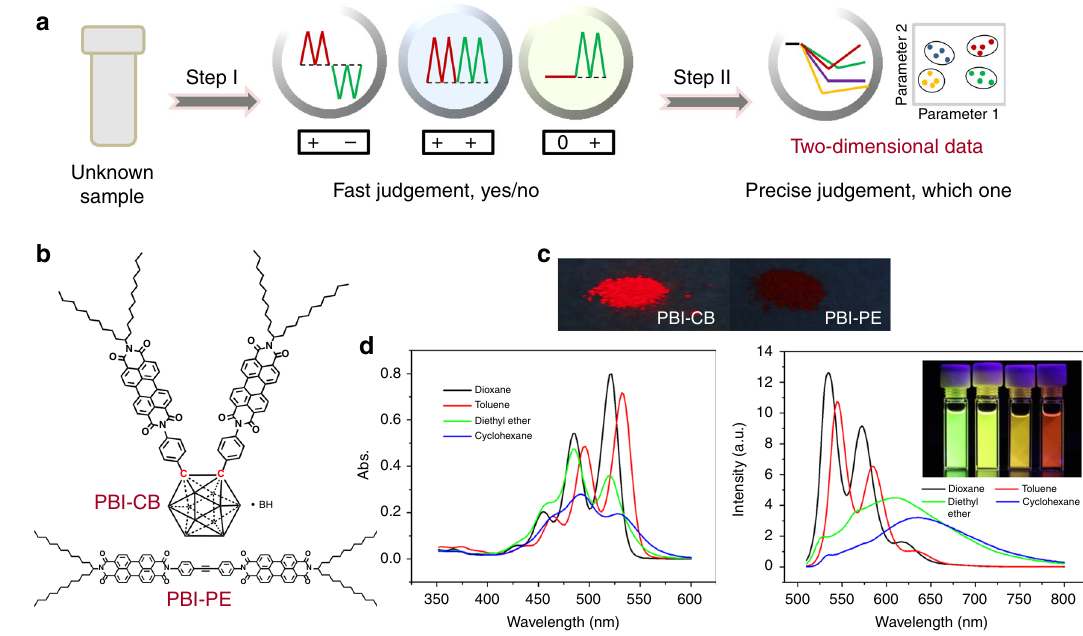
Fig. 1 Analytical strategy and fl uorescent property of PBI-CB. a Schematic representation of the two-step judgment strategy for differentiation and identi fi cation of illicit drugs via scent snif fi ng. b Chemical structures of PBI-CB and PBI-PE. c Fluorescent images of PBI-CB and PBI-PE in solid state under UV light (365 nm). d UV-vis absorption spectra and fl uorescence emission spectra of PBI-CB recorded in different solvents at a concentration of 5.0 × 10 − 6 mol L − 1 and at room temperature ( λ ex = 480 nm). Inset: fl uorescent pictures of the four solutions under UV light (365